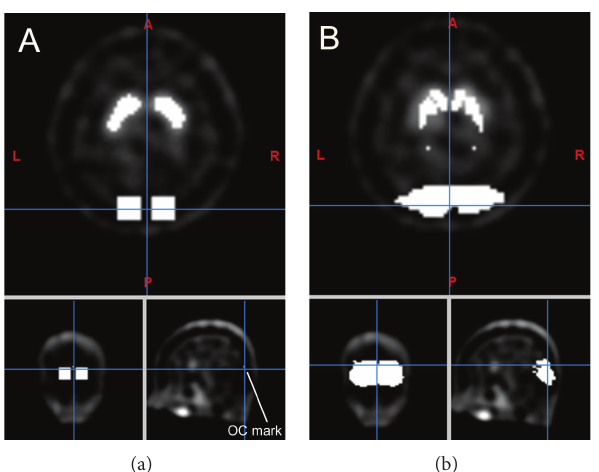
Figure 1: ROIs of striatum and occipital lobe in the TRODAT-1 SPECT of a 23-year-old woman (native space). (a) 70% threshold-ROI method and (b) SPECT-normalization